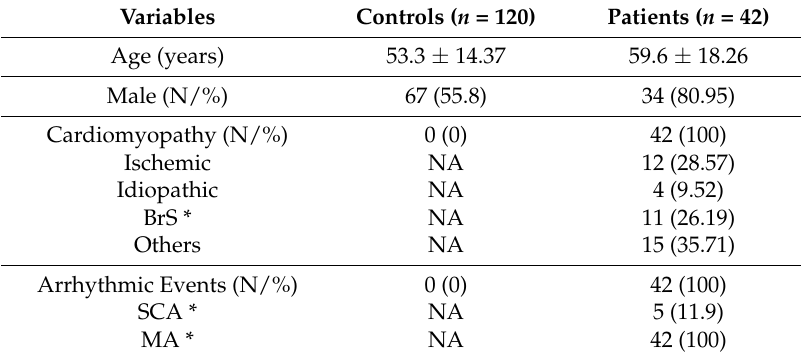
Table 1. Population characteristics.